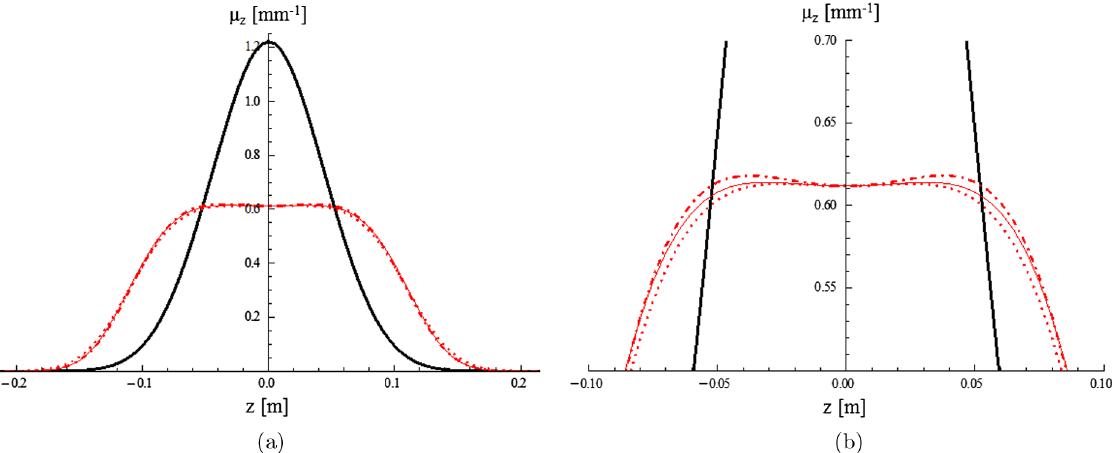
¼ 135 ( L ¼ 5 × 10 34 cm − 2 s − 1 ) for the four HL-LHC configurations FIG. 5. Line PU density [mm − 1 ] vs z [m] (a) normalized to μ 0 tot described in Table III, with the black solid line corresponding to case a, and the red solid, dotted-dashed, and dotted lines associated to the cases b, c, and d, respectively. The beneficial impact of the crab-kissing scheme (last 3 cases) is very clear compared to the present HL-LHC baseline (first case), and only a zoom (b) can actually help in appreciating the tiny differences between these three